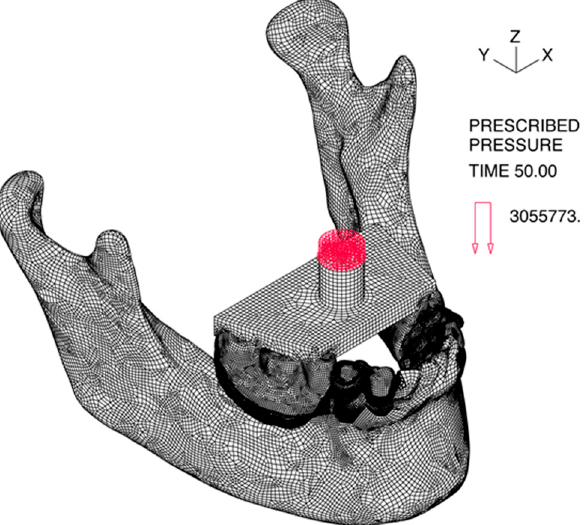
Figure 2. Loading conditions applied to all three models as a uniform pressure equivalent to a 240 N force along the Z direction (purely vertical), applied to a 78.5 mm 2 circle in the geometric center of the loading plate, designed by CAD for perfect fitting to the occlusal surfaces of the acrylic teeth.